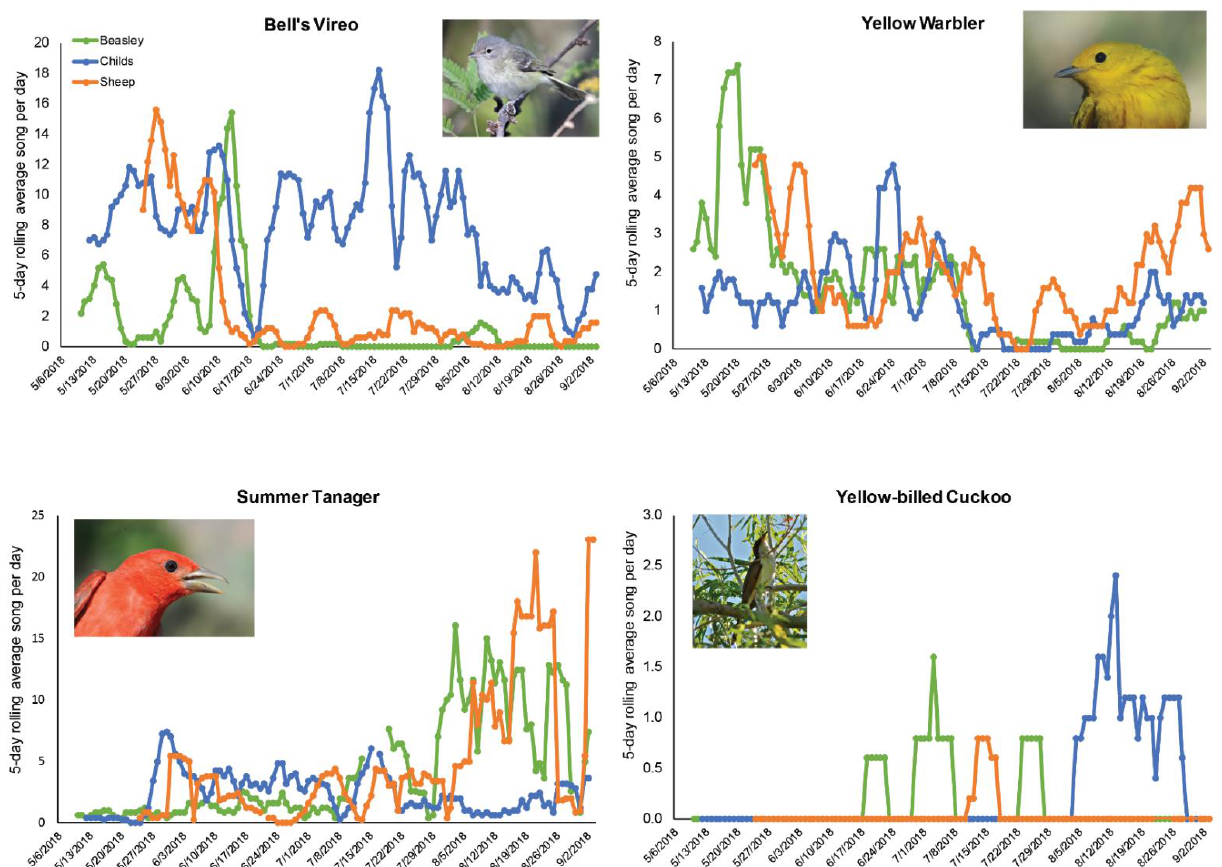
Figure 2. Vocal activity of four species of riparian birds plotted as a 5-day rolling average across three passive acoustic recorders per reach along the Lower Verde River, central Arizona (USA). Reaches listed in order from north to south (Beasley to Sheep). Photo credits: YEWA, SUTA by Kristan Godbeer, YBCU by Steve Prager, BEVI James Hully/Macaulay Library at the Cornell Lab (ML48451521).